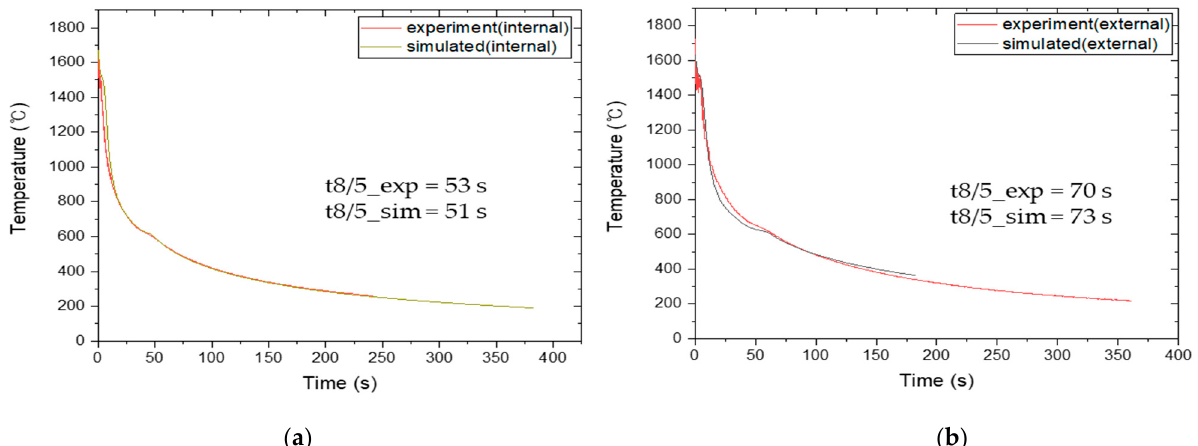
Figure 6. Comparison of experiment and simulated results: ( a ) SAW internal pass and ( b ) SAW external pass.